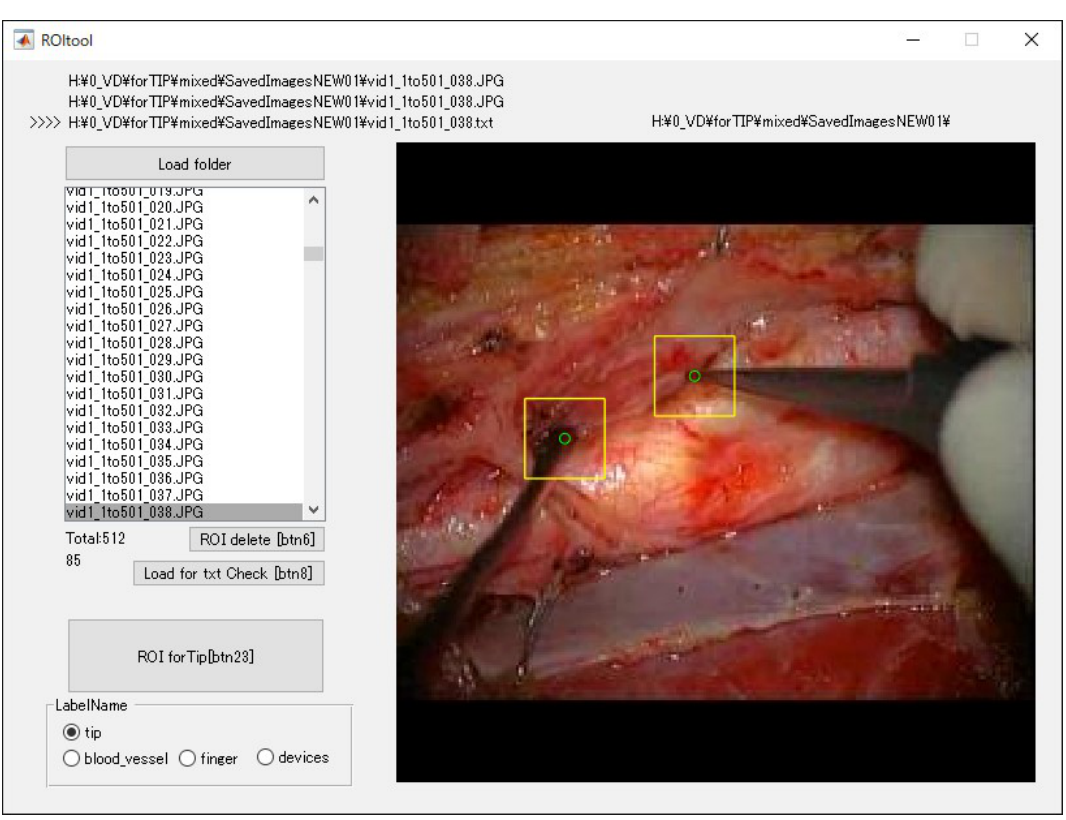
Figure 3. The software for supervised data to detect the end of surgical instruments. The green circles indicate the end of a surgical instrument, while the yellow bounding boxes are the 32 × 32-pixel ROIs.